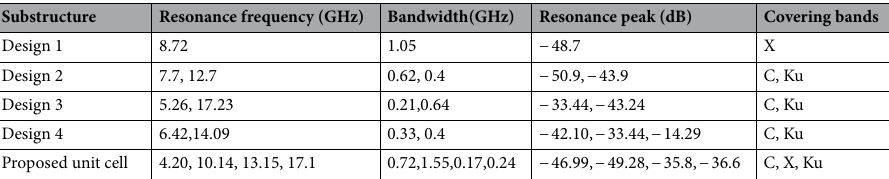
Table 2. Transmission coefficient (S 21 ) of successive steps for the proposed unit cell.